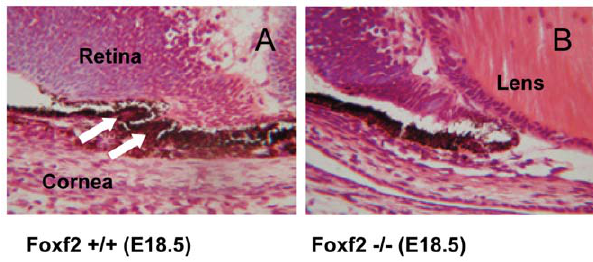
Figure 6. Comparison of iridocorneal development in homo- zygous Foxf2 W174R embryos. A , The ciliary body is beginning to form in E18.5 wildtype embryos, showing two finger-like projections of evaginated tissue (white arrows). B , Formation of the ciliary body is absent in the E18.5 homozygous Foxf2 W174R mutant mouse eye.